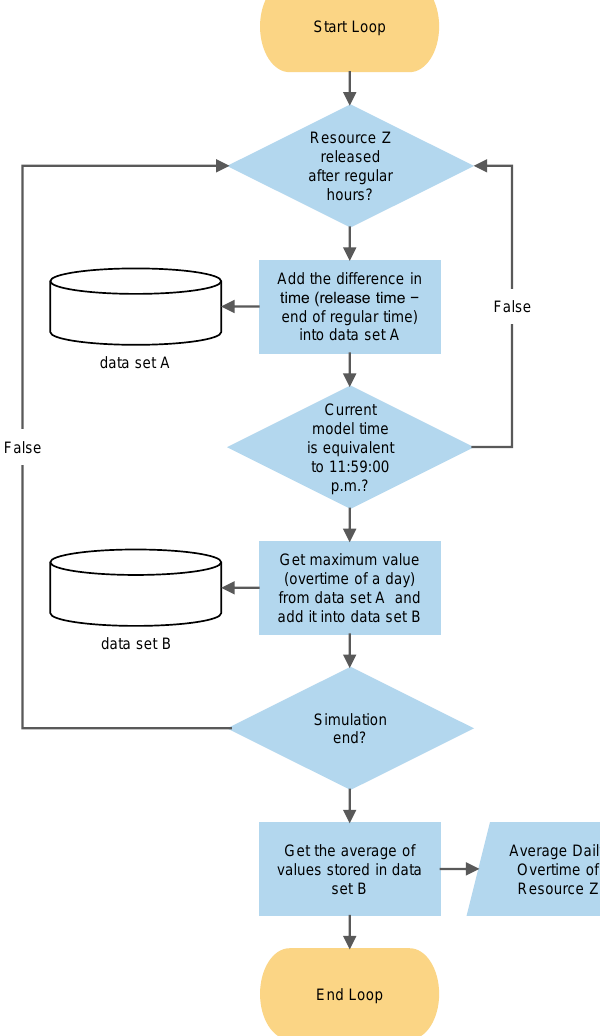
Figure 3. Flowchart of the calculation algorithm of average daily overtime of a resource in the simulation